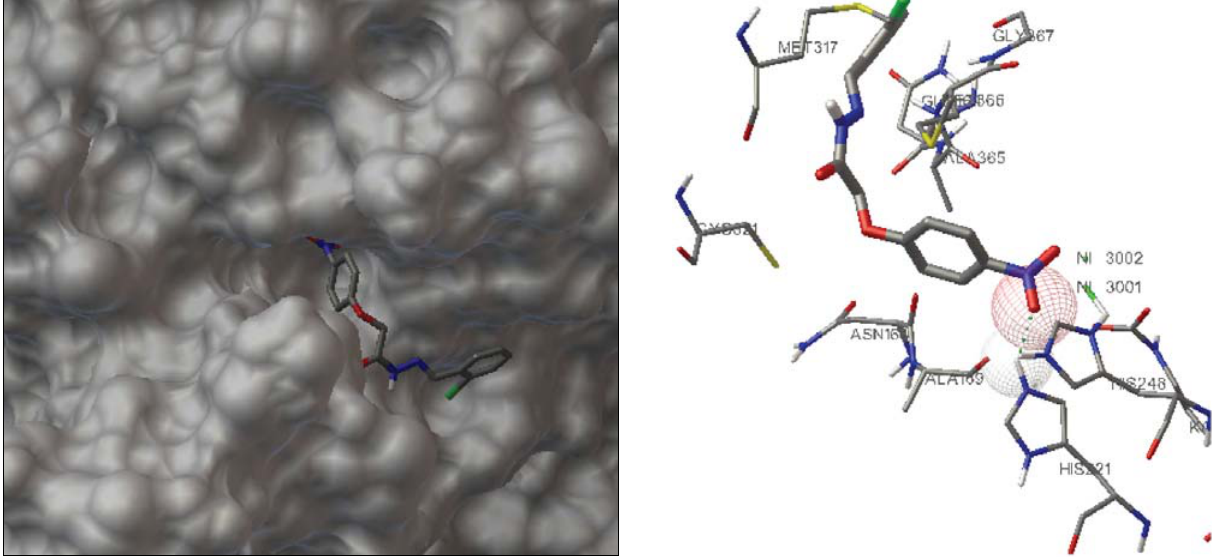
Figure 5. Binding mode of compound 1 with H. pylori urease. The enzyme is shown as surface, and molecule of 1 is shown as sticks (left). The hydrogen bond is displayed as a dashed line (right).